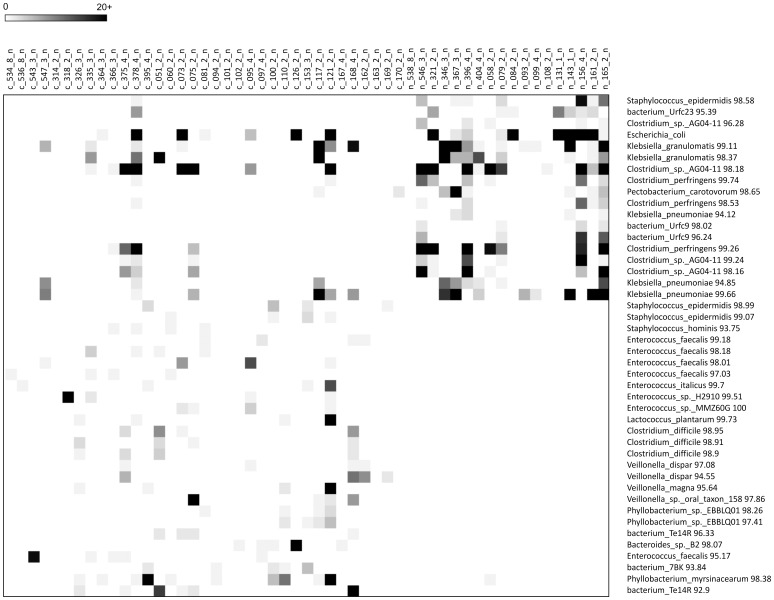
Heat map of selected OTU (98% similarity) correlating with NEC status during the week of diagnosis.Controls are shown on the left (c_###) and NEC cases on the right (n_###). The number of sequences detected per sample for each OTU is indicated by degree of shading, with the darkest shade correlating with the highest number of sequences. OTUs more frequently observed in NEC cases are shown on the top and OTUs less frequently observed are shown on the bottom.